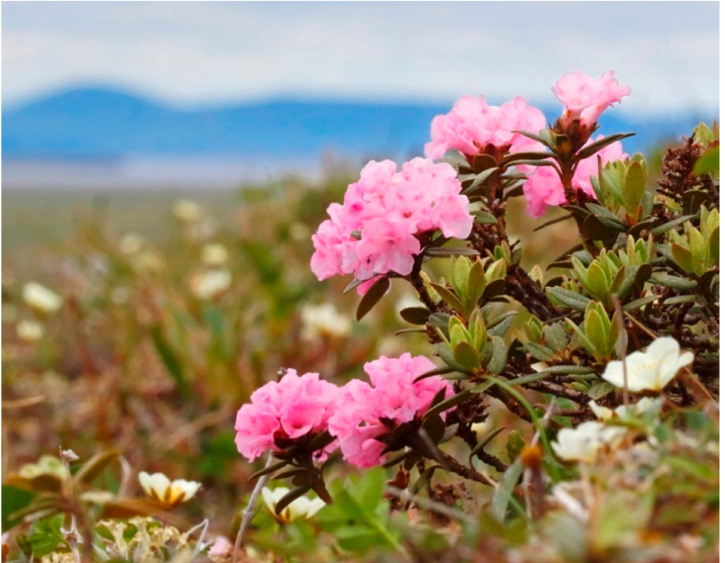
Figure 1. Rhododendron adamsii Rehder (Sagan Dalya) in its natural habitat (Republic Sakha Yakutia, Lena River delta, Kubalakh-Aryta Island, Orto-Khaya Mountain,